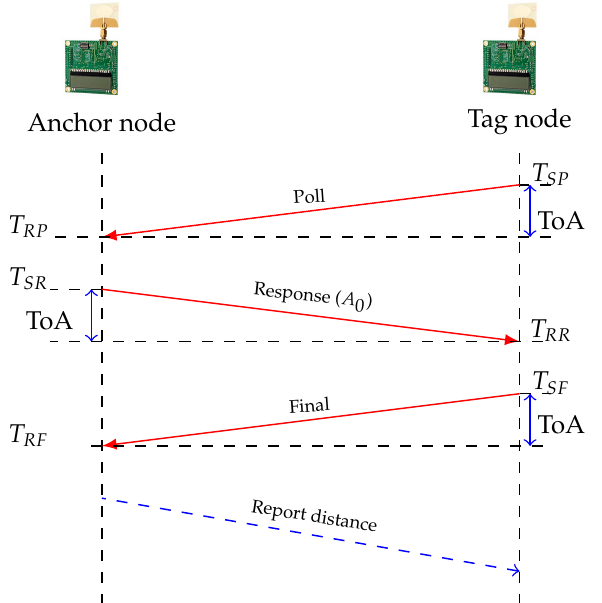
Figure 2. Average distance measurement based on the TWR technique for Decawave nodes.